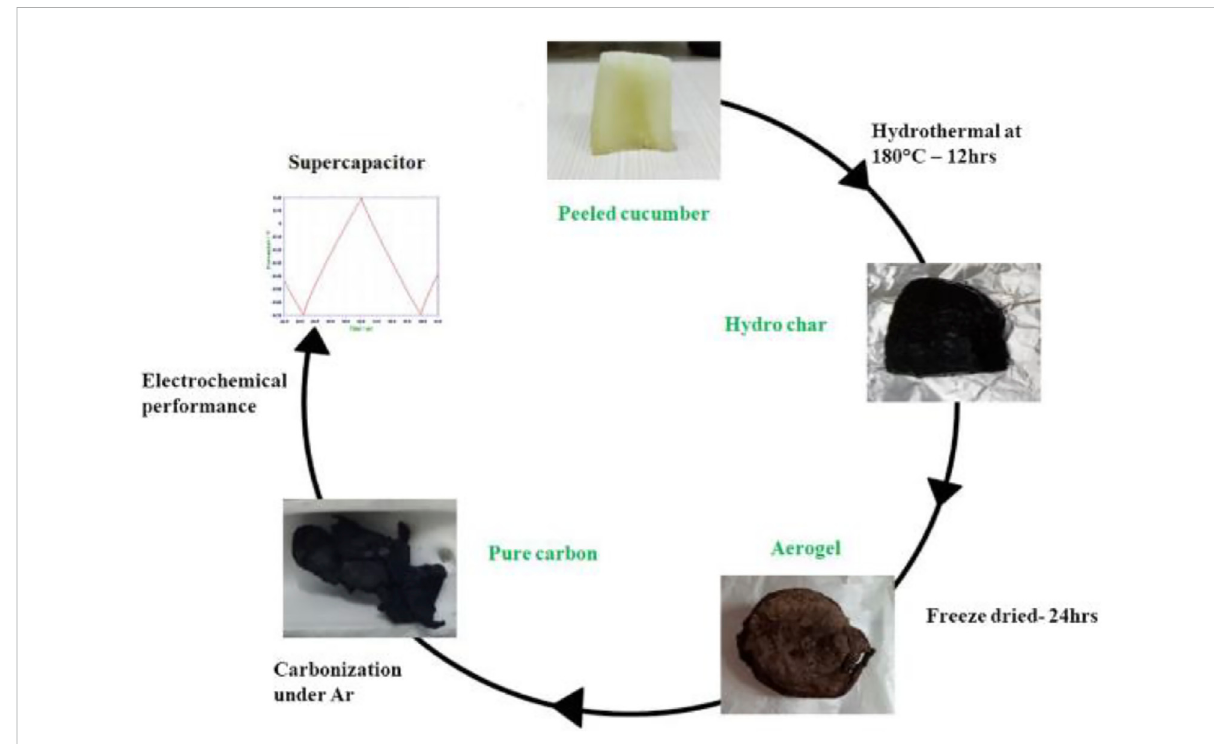
FIGURE 16 Schematic diagram for the synthesis route of carbon nanosheets from cucumber (Gopalakrishnan and Badhulika